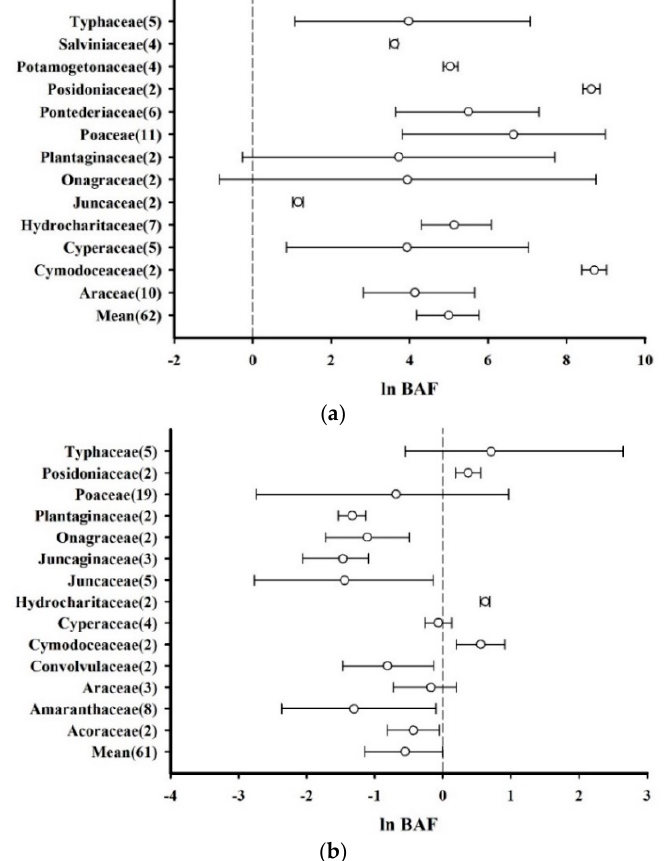
Figure 3. Biological accumulation factors (BAFs) of plant roots based on families, presented as the mean effect size and 95% CI. ( a ) Absorption of Hg from water by plant roots. ( b ) Absorption of Hg from sediments by plant roots. The numerals after the family names represent the number of observations. “Mean” indicates the overall effect considering all